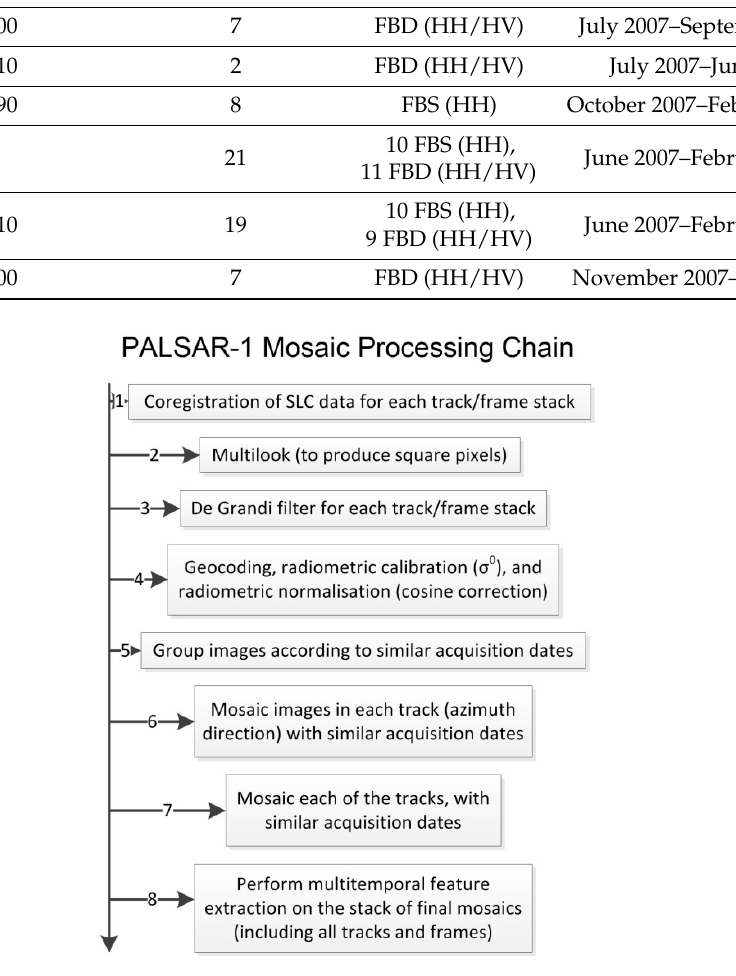
Figure 3. PALSAR-1 mosaic processing chain. The last step (8) included analysis of the mosaics and extraction of the mean mosaic backscatter.